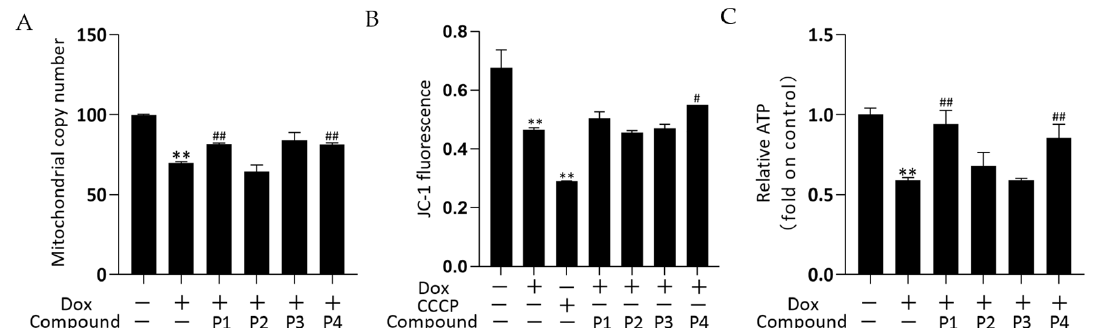
Figure 5. Effects of Hippophae rhamnoides L. phenylpropanoids on the mitochondrial function of zebrafish. ( A ) Mitochondrial copy number in each group of zebrafish obtained using real-time quantitative PCR. ( B ) Mitochondrial membrane potential of each group in zebrafish determined using flow cytometry. ( C ) ATP levels in each group of zebrafish obtained using an ATP assay kit. ** p < 0.01 vs. the control group; # p < 0.05, ## p < 0.01 vs. the Dox group.